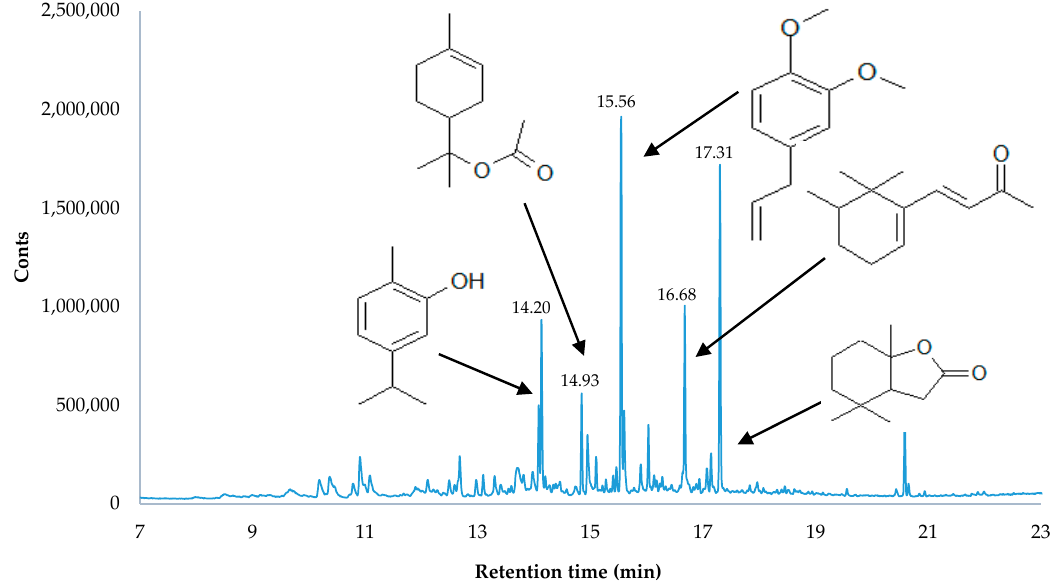
Figure 4. Chromatograms SPME–GC for the volatile fraction of dry material from Coriandrum sativum L.